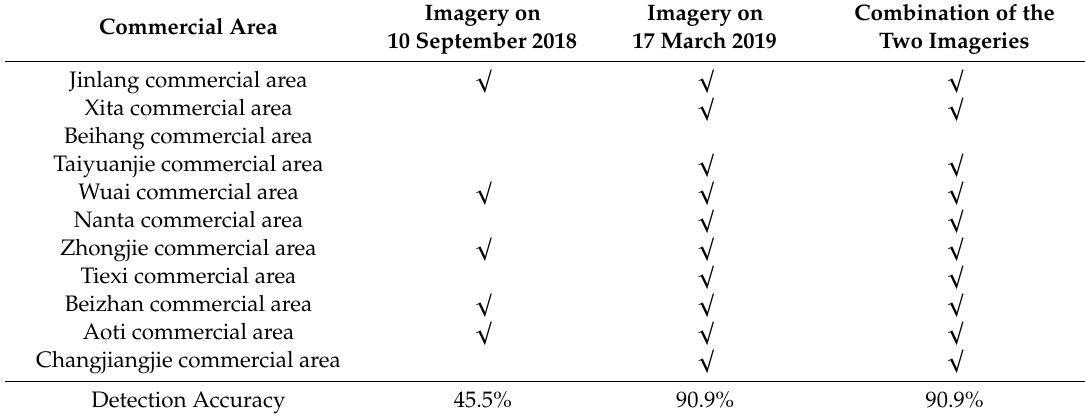
Table 5. Detection accuracy table of Shenyang’s